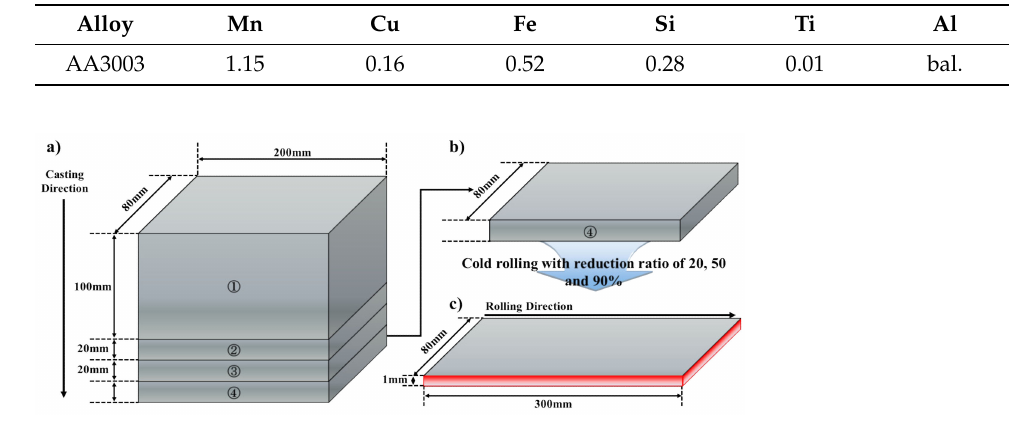
Figure 1. ( a ) Schematic diagram of DC casting direction and dimensions, ( b ) positions of a sample taken from the ingots for a test, and ( c ) dimensions of cold-rolled